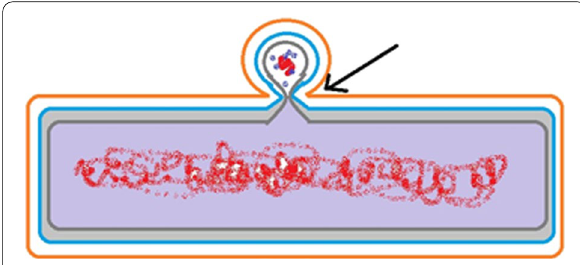
Fig. 4 The blebbing of OMV from atypical Gram-negative bacteria (arrow indicates the point of